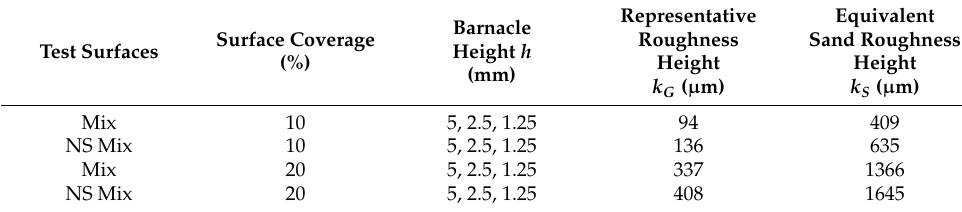
Table 1. Roughness length scales of test surfaces, adapted from [26] Uzun et al., 2020.